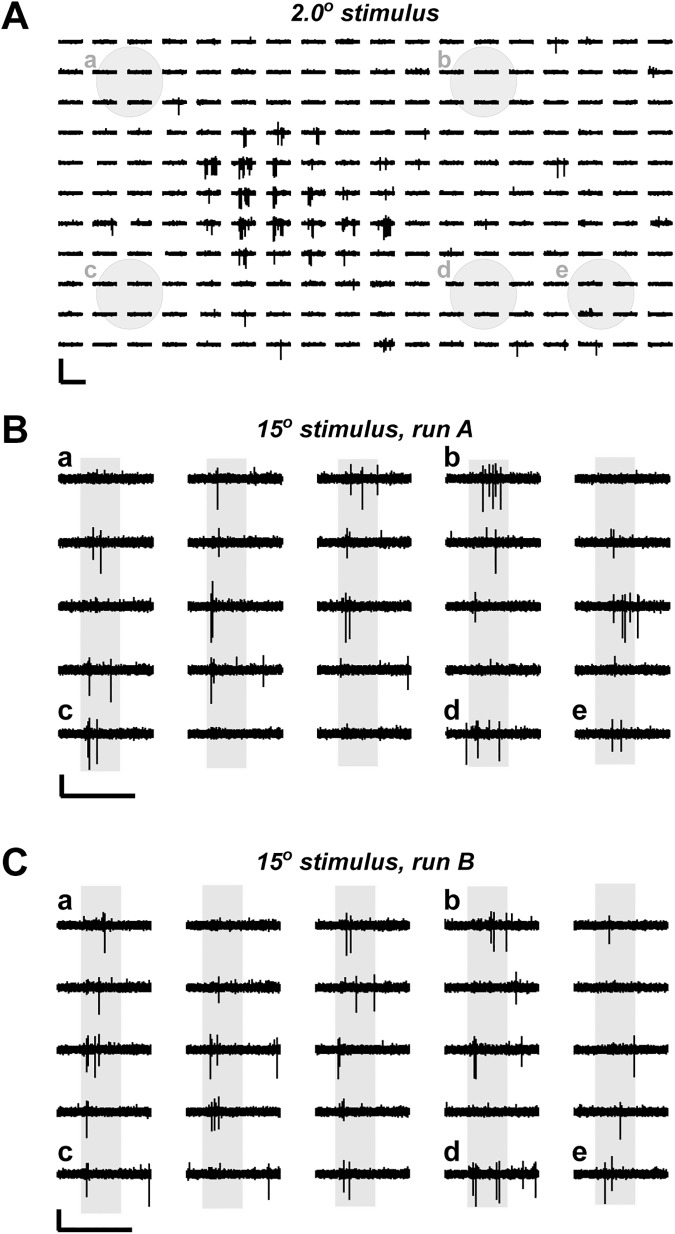
Large flashing spots evoked neuronal activity over much wider visual field area than small spots.(A) Trace samples of responses evoked by 2-degree spots. Trace position corresponds to the stimulus location on the monitor. Each trace is 2.0 s long; a 0.6 s stimulus was presented 0.4 s from the trace start. Grey filled circles with letters correspond to marked 15-degree stimulus locations shown in B and C. (B) and (C) Trace samples of responses evoked by 15-degree spots. Grey background bars indicate when the stimulus was presented. Letters by traces indicate responses corresponding to stimuli presented at locations shown in A. Scale bars are 250 μV and 2 s.